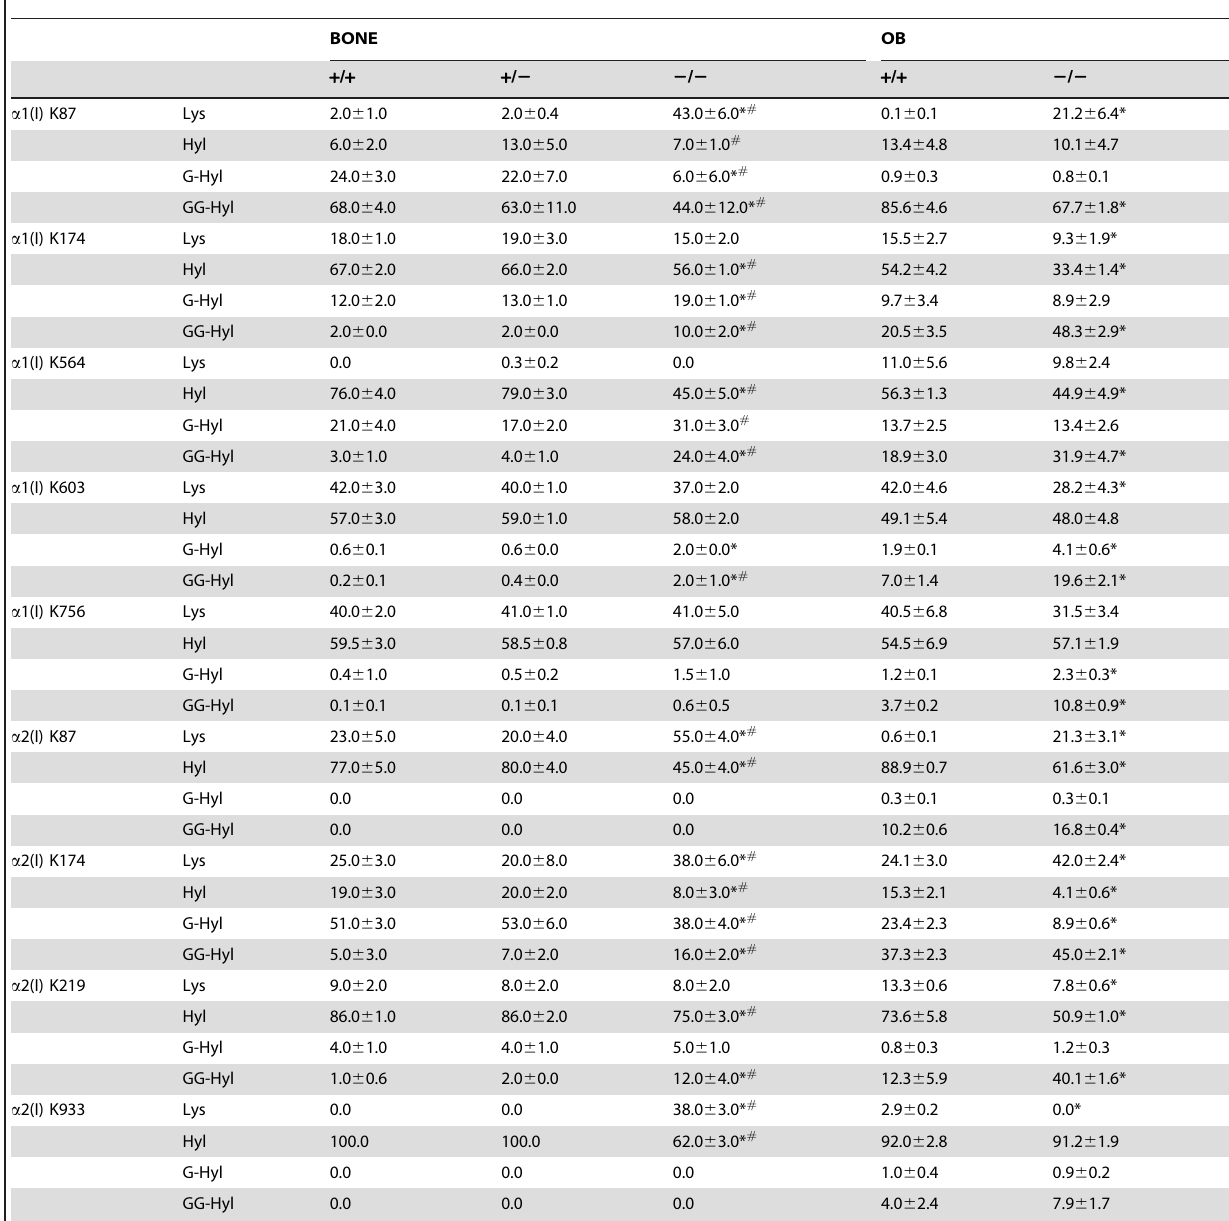
Table 2. Post-translational modification of type I collagen lysine residues.